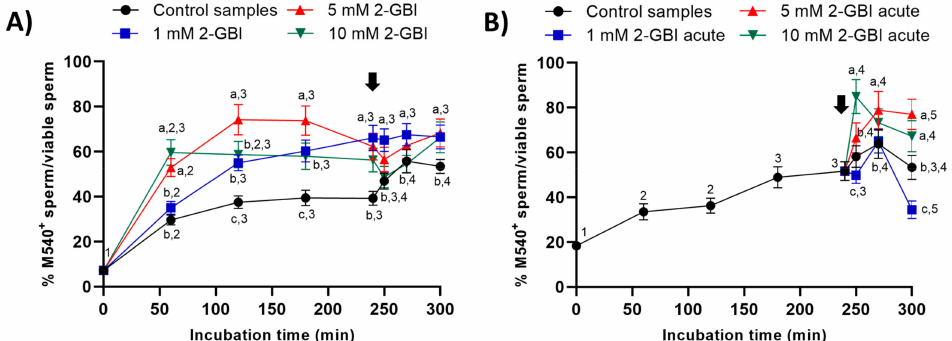
Figure 8. Percentages of viable sperm with high lipid disorder (M540 + ) in relation to total viable sperm (YO-PRO-1 − ) throughout the incubation of sperm samples in capacitating medium (control samples) and capacitating medium plus 1 mM, 5 mM and 10 mM 2-GBI. The inhibitor was added to capacitating medium either at 0 min in experiment 1 ( A ) or after 240 min of incubation in experiment 2 ( B , acute). Di ff erent superscript letters (a–c) indicate significant di ff erences ( p < 0.05) between samples within the same time point, and di ff erent superscript numbers (1–5) indicate significant di ff erences ( p < 0.05) between time points within a given treatment. Results are expressed as mean ± SEM ( n = 10). The arrow indicates the time at which 10 µ g / mL of progesterone was added to all samples (i.e., 240 min of